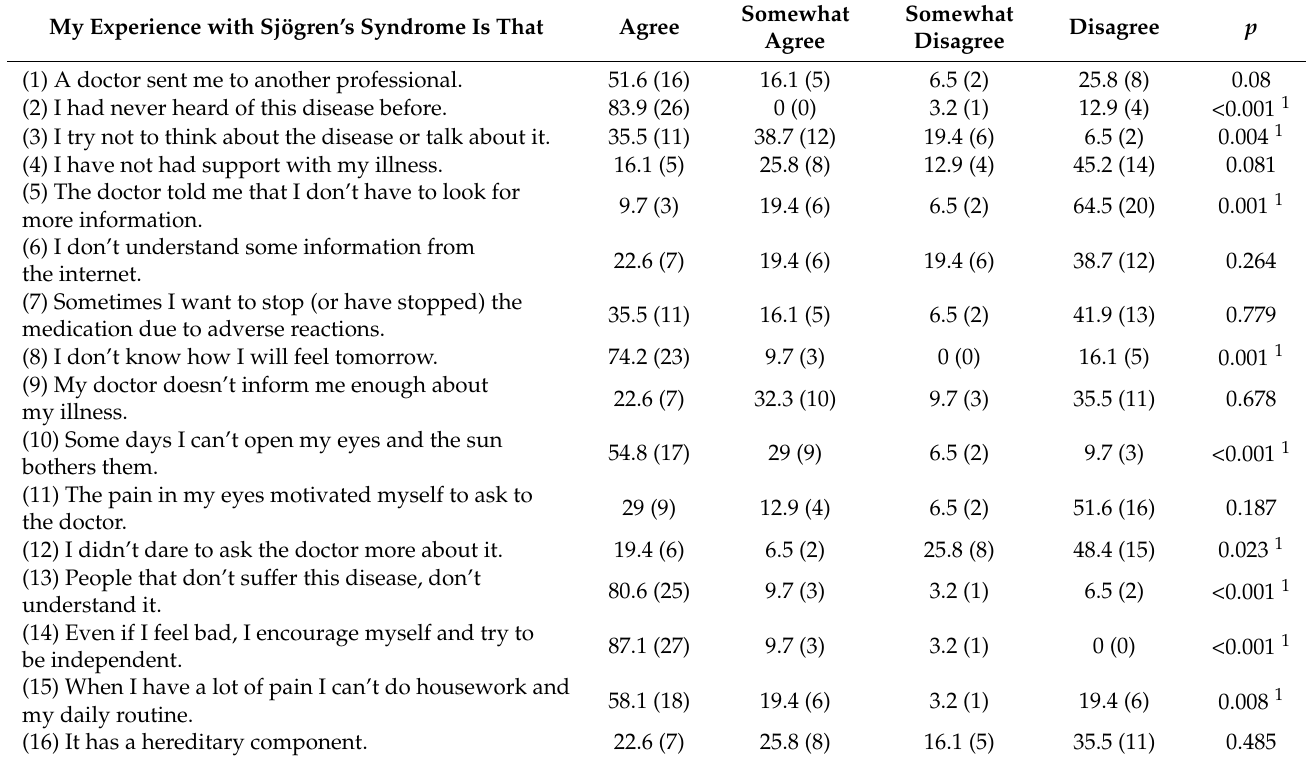
Table A1. Affirmations of illness